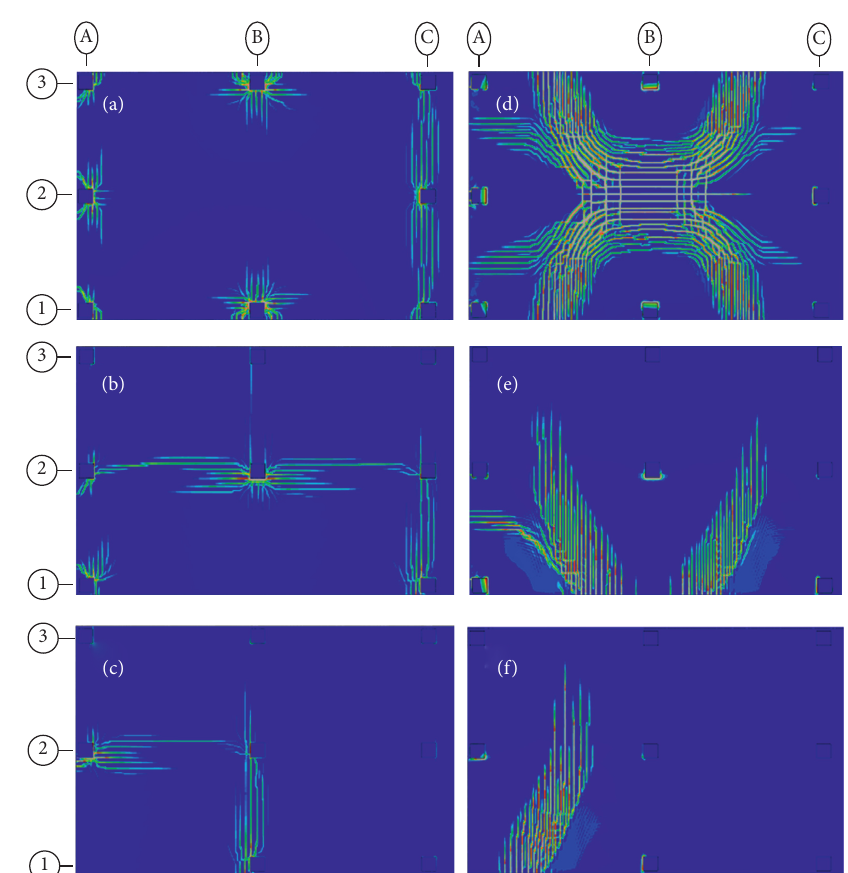
Figure 11: Plastic strains at upper (a–c) and lower (d–e) slab surfaces at station A (first bar yielding): model RI (a, d), model RP (b, e), and model RC (c,